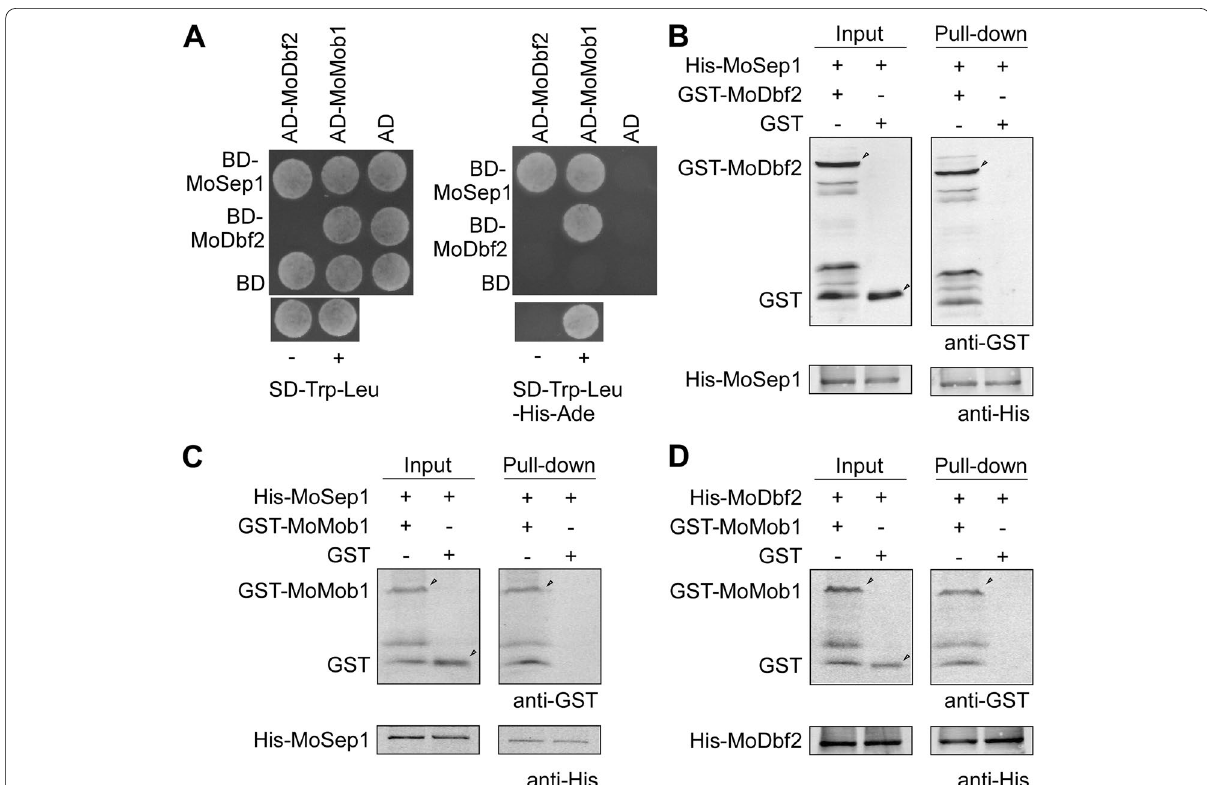
Fig. 1 MoSep1 interacts with MoDbf2 and MoMob1. A Yeast two-hybrid analysis of the interaction between MoMSep1 and MoDbf2. MoMob1 was inserted into vectors pGADT7 and pGBKT7. BD-MoMSep1 and AD-MoDbf2, BD-MoMSep1 and AD-MoMob1, and BD-MoDbf2 and AD-MoMob1 were co-introduced into the yeast AH109 strain and then incubated on SD-Leu-Trp (as control) and SD-Leu-Trp-His-Ade (for selection) for 5 days. MoSep1, MoDbf2, and MoMob1 interacted with each other. B In vitro pull-down assay between His-MoSep1 and GST-MoDbf2. Recombinant His-MoSep1 bound to histidine beads was incubated with bacterial cell lysate containing GST-MoDbf2 or GST, respectively. Eluted protein was analyzed by immunoblot (IB) with monoclonal anti-His and monoclonal anti-GST antibodies. MoSep1 interact with MoDbf2. C In vitro pull-down assay between His-MoSep1 and GST-MoMob1. Recombinant His-MoSep1 bound to histidine beads was incubated with bacterial cell lysate containing GST-MoMob1 or GST, respectively. Eluted protein was analyzed by immunoblot (IB) with monoclonal anti-His and monoclonal anti-GST antibodies. MoSep1 interact with MoMob1. D In vitro pull-down assay between His-Dbf2 and GST-MoMob1. Recombinant His-MoDbf2 bound to histidine beads was incubated with bacterial cell lysate containing GST-MoMob1 or GST, respectively. Eluted protein was analyzed by immunoblot (IB) with monoclonal anti-His and monoclonal anti-GST antibodies. MoDbf2 interact with MoMob1. His, histidine. GST, glutathione